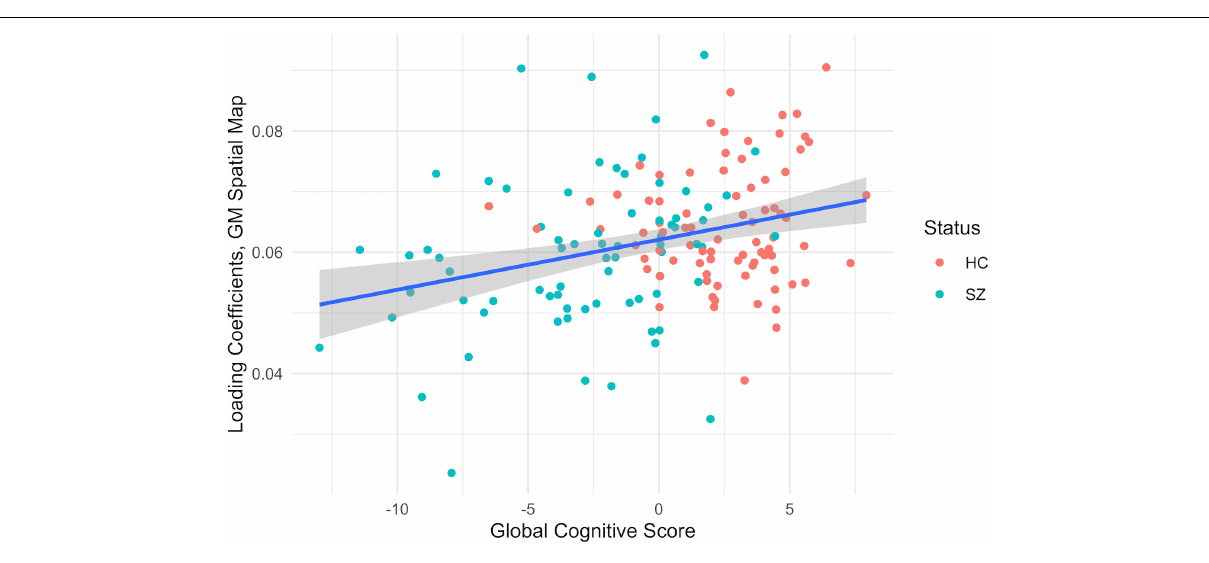
FIGURE 5 | MANCOVA results between the subjects gray matter loading coefficients from the third component pair (y-axis) and the global cognitive score (x-axis), F = 9.70, p < 0.002, corrected for multiple comparisons, healthy controls (HC) in red and patients with schizophrenia in teal (SZ). The gray shading indicates a confidence interval of